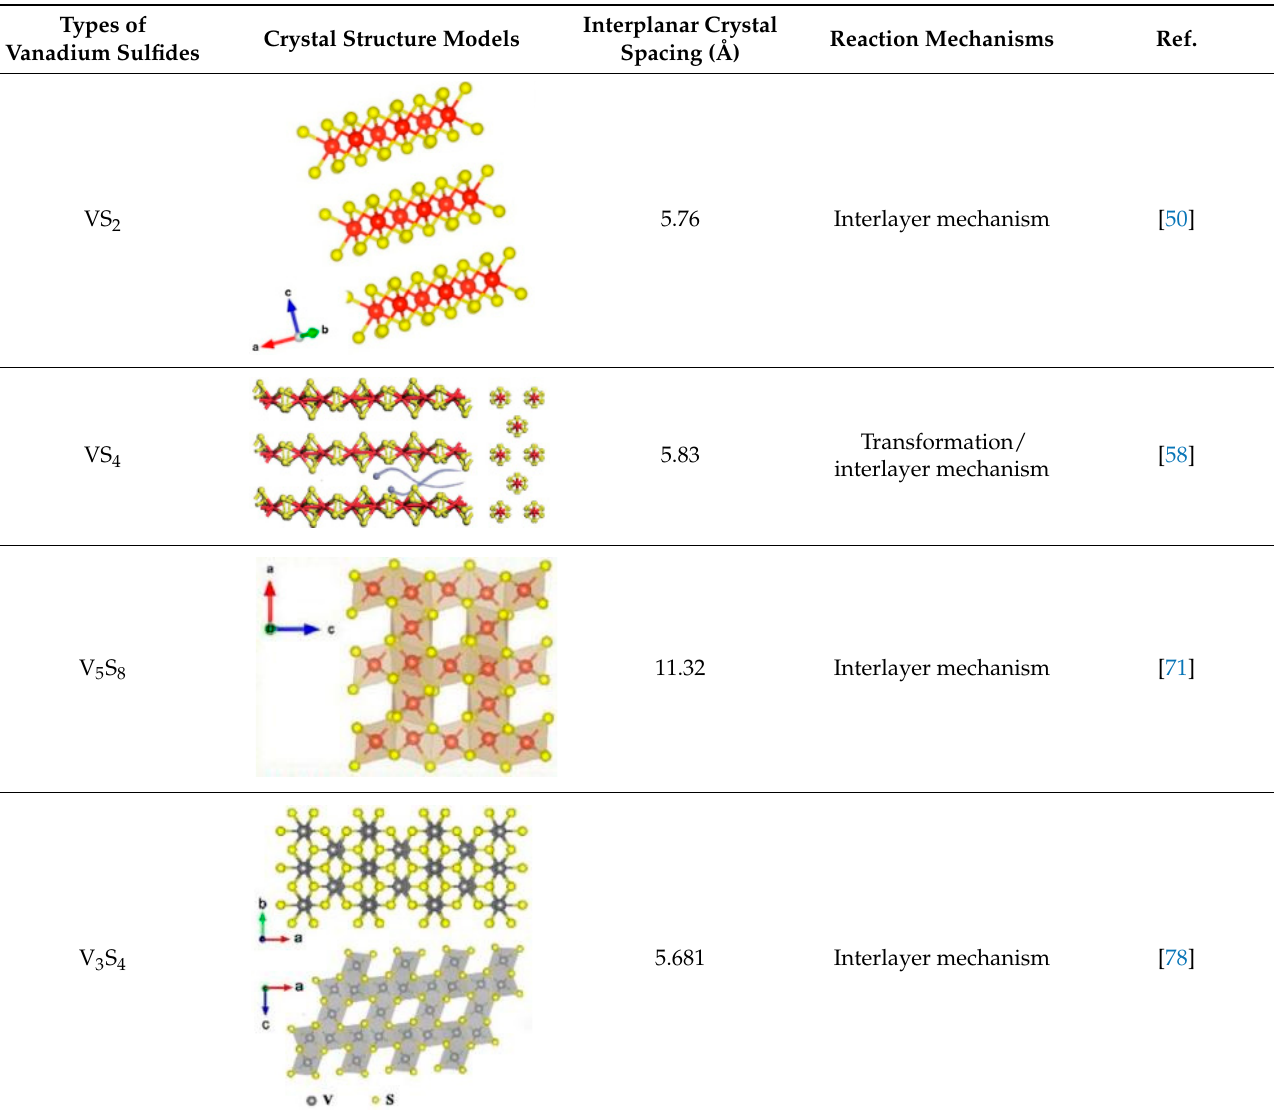
Table 1. Summary of the structure and mechanism of vanadium sulfide cathode materials in AZIBs.